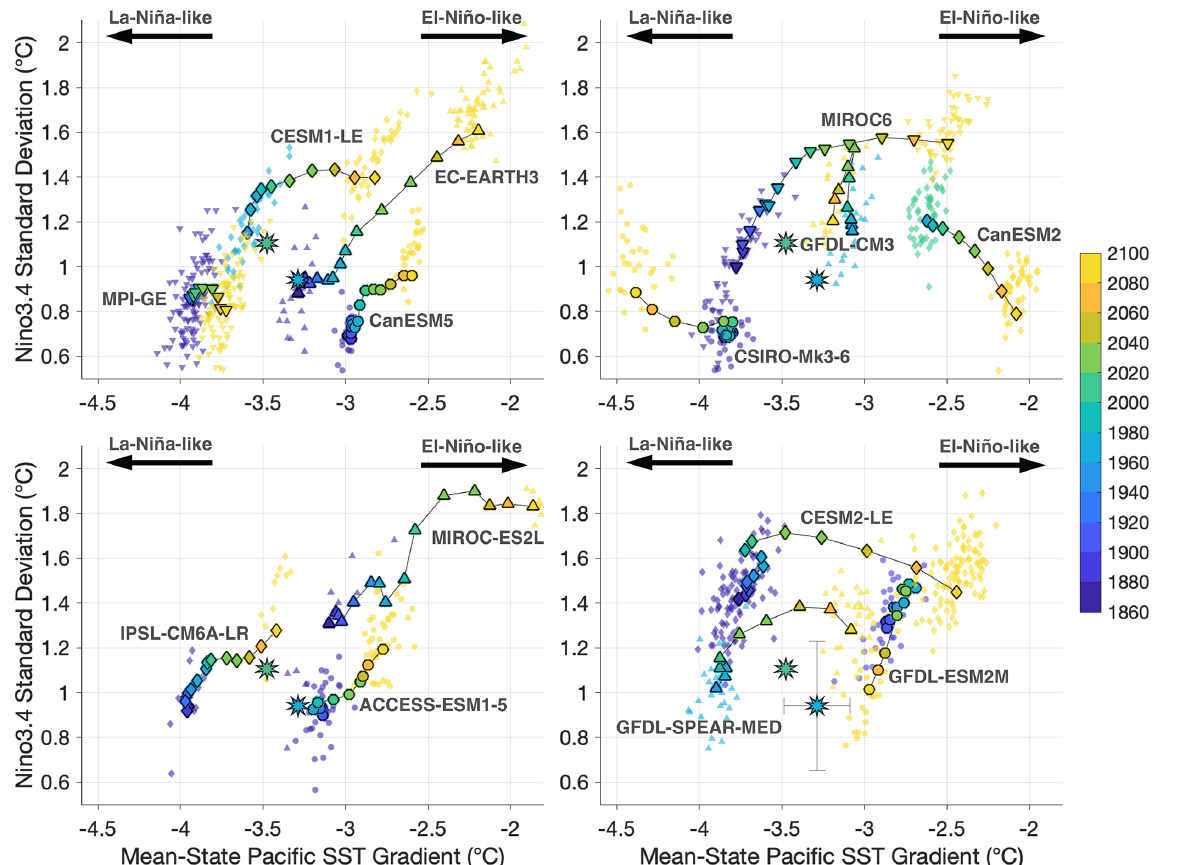
Figure 9. Time evolution of the 30-year running-mean DJF tropical Pacific SST gradient (defined as in Fig. 7; x axis) and 30-year running standard deviation of DJF Niño3.4 variance ( y axis) in each SMILE. Symbols with black edges show the ensemble mean for overlapping 30- year periods every 15 years between 1850 and 2100, with the center year of the averaging period computed as indicated by the fill color. The 30-year running-mean DJF tropical Pacific SST gradient and 30-year running standard deviation of DJF Niño3.4 in each ensemble member is shown for the first and last averaging periods (symbols without black edges). The observational values for ERSST5 during the period 1951–1980 and 1990–2019 are shown with light blue and light green stars, respectively. The internal variability in each quantity expected in a single 30-year period, estimated from the multi-model mean of the ensemble mean variance in each quantity, is depicted with a 95% confidence interval behind the light blue star in the bottom right